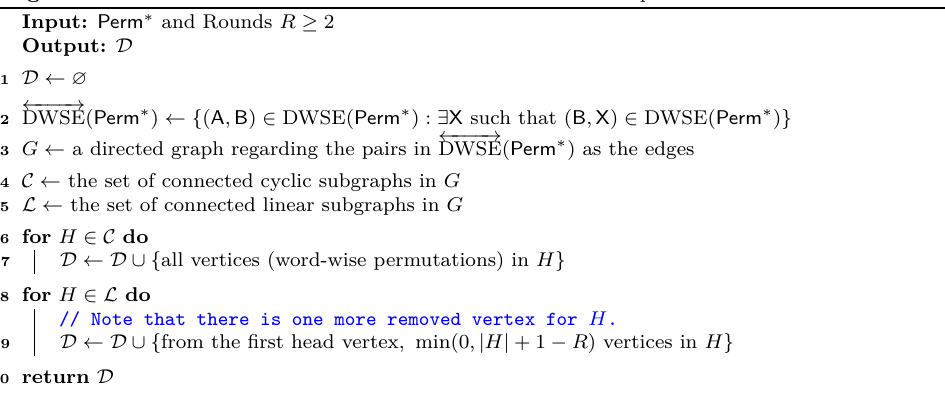
Algorithm 2: R -Round Permutation Characteristics of AES-like Cipher